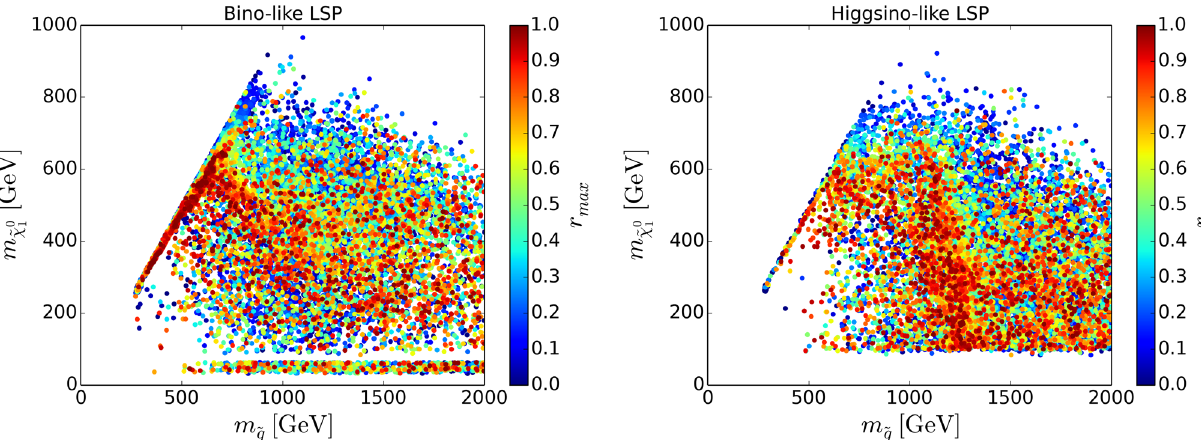
Fig. 3 Maximum r value reported by SModelS for allowed points, for gluino masses up to 2 TeV, for bino-like LSP scenarios (left) and higgsino- like LSP scenarios (right). Points are sorted from low to high r -values, with the highest values of r shown on